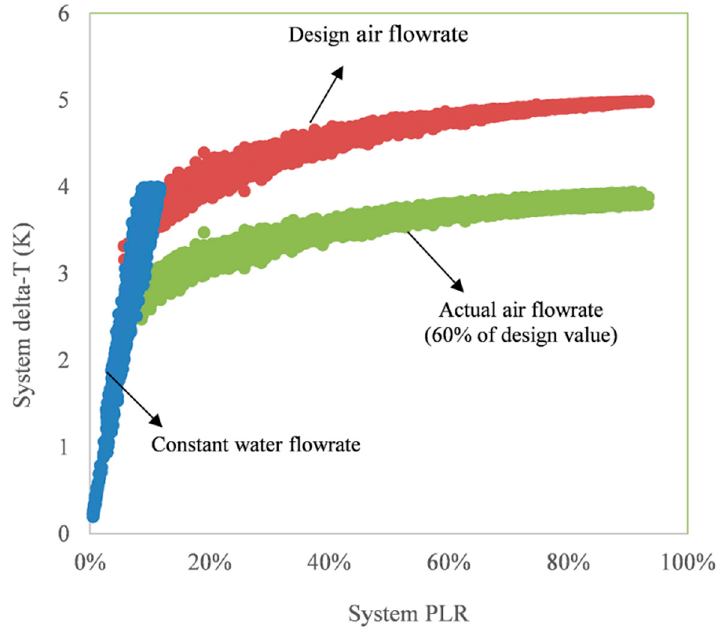
Figure 4. Performance map of system delta-T under typical faults.